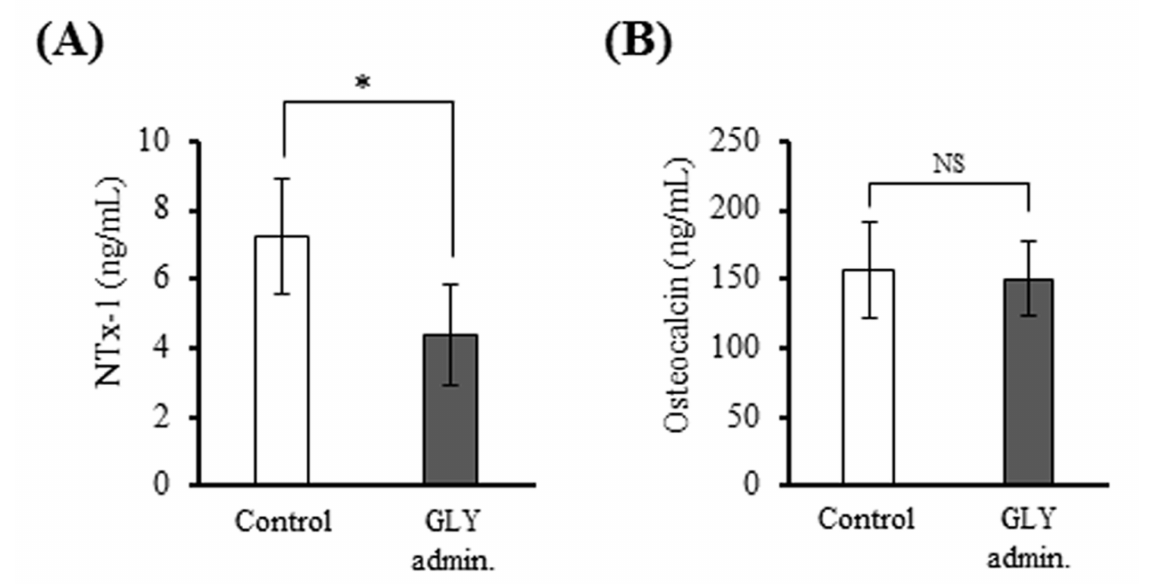
Figure 6. Comparison of the number of bone biomarkers in sera of ligature-induced periodontitis. ( A ) Serum concentrations of NTx-1 as a bone resorption marker. ( B ) Serum concentrations of osteocalcin as a bone formation marker. Data are presented as the mean ± SD from six or twelve rats per group. * p < 0.05 compared with control. NS indicates no significant differences. Control; group of administration of distilled water for 20 days ( n = 6), GLY admin.; group of oral administration with 60 mg/kg of GLY extracts for 20 days ( n =